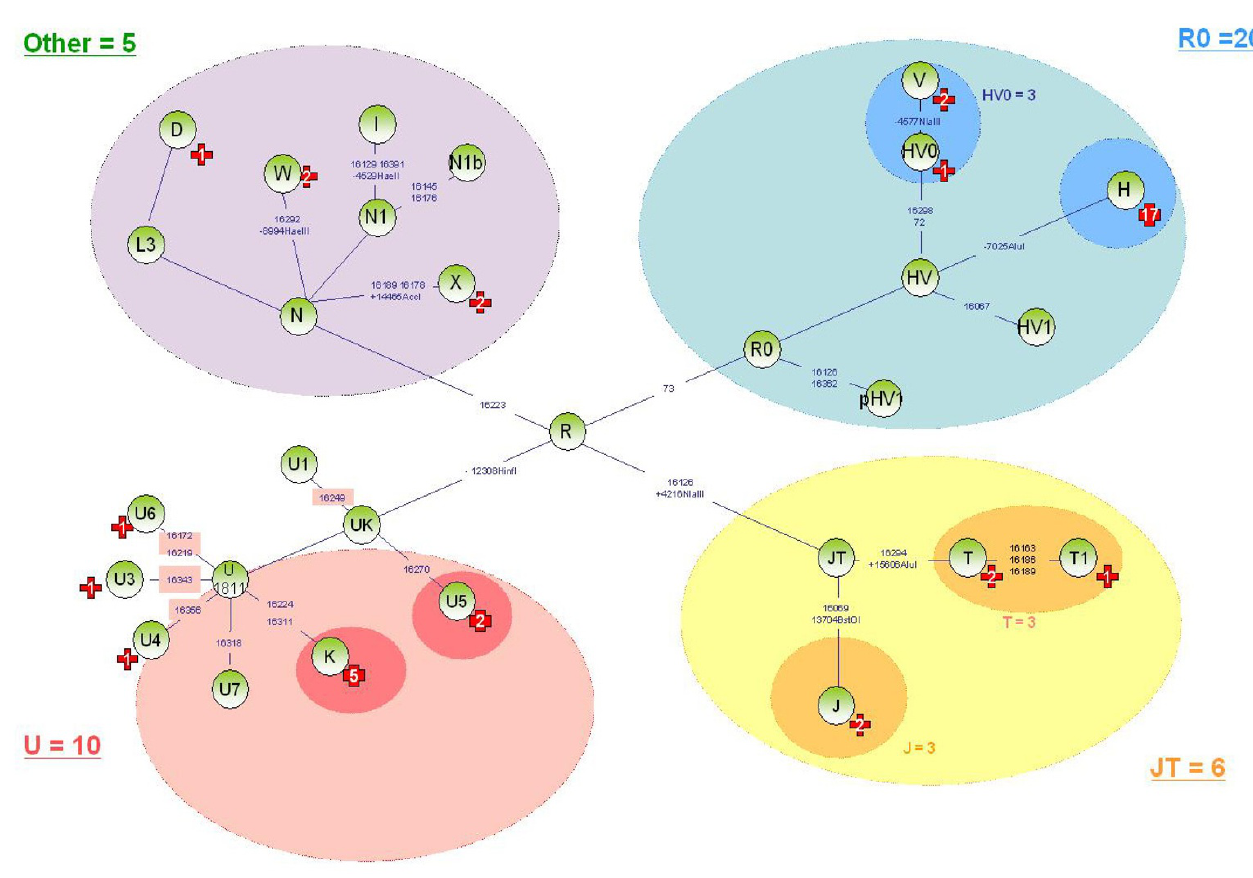
Figure 1 Phylogenical repartition of the 41 OPA1 mutation carriers . The phylogenic tree was based on recent total sequencing studies of mitochondrial DNA [11,12]; the new haplogroup nomenclature is used[17]. The different polymorphisms used for